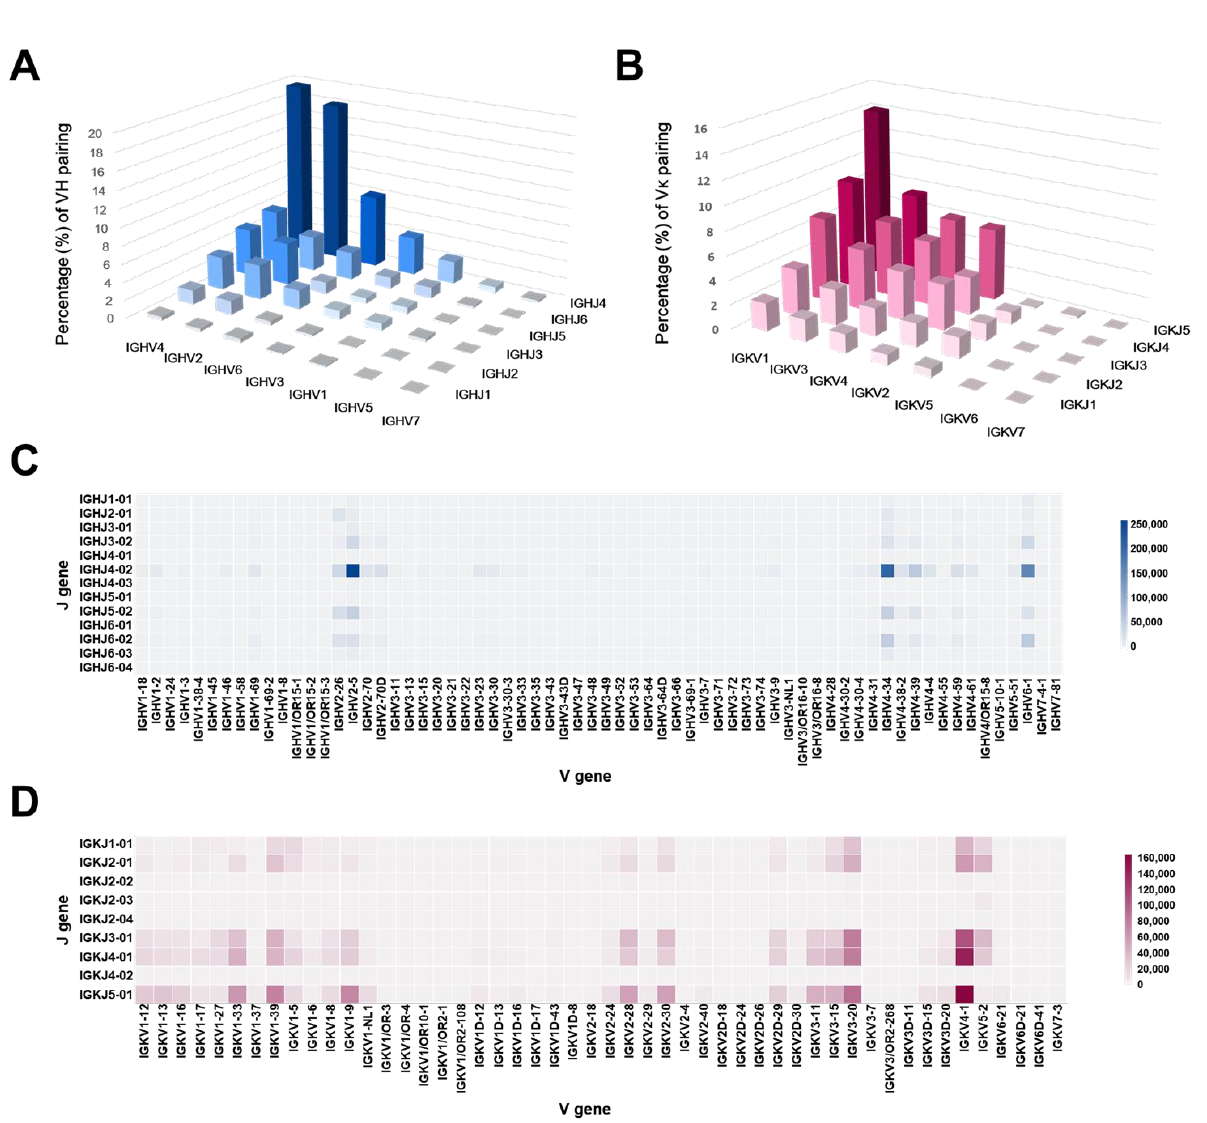
Figure 4. Pairing and frequencies of germline V and J gene families and segments in each heavy chain variable (VH, blue) and κ light chain variable (V κ , red) domain of the constructed library. The pairs of germline V and J gene families in VH ( A ) or V κ ( B ) are expressed as percentage bar graphs. The pairing frequencies of 66 IGHV and 13 IGHJ gene segments in VH ( C ) or 50 IG κ V and 9 IG κ J in V κ ( D ) are illustrated as two-dimensional heatmaps.